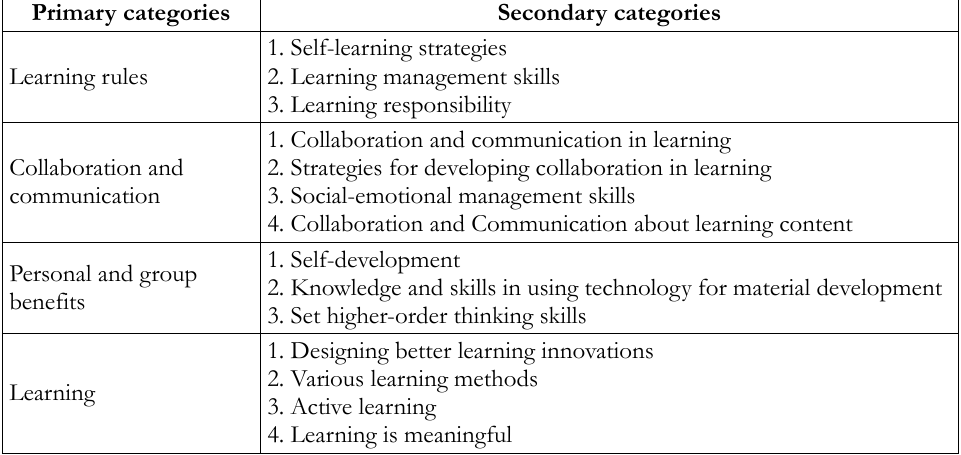
Table 3. Benefits of Digital Eco-Learning with Student Worksheet